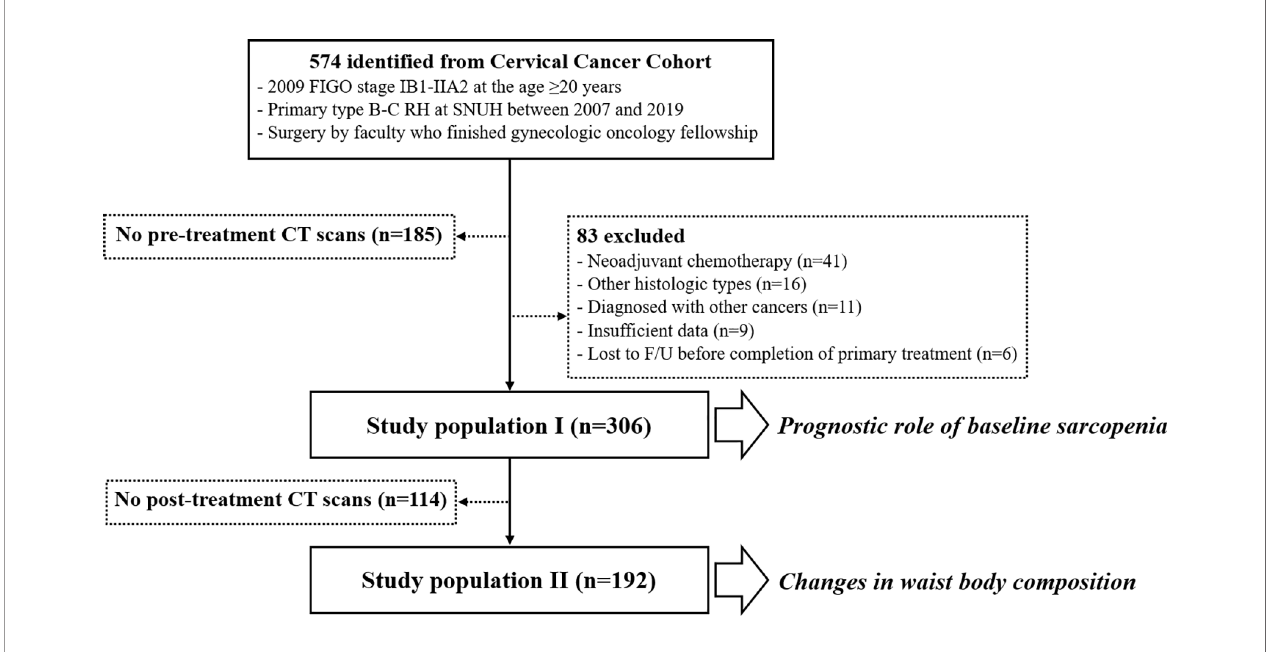
FIGURE 1 | Flow diagram depicting selection of study